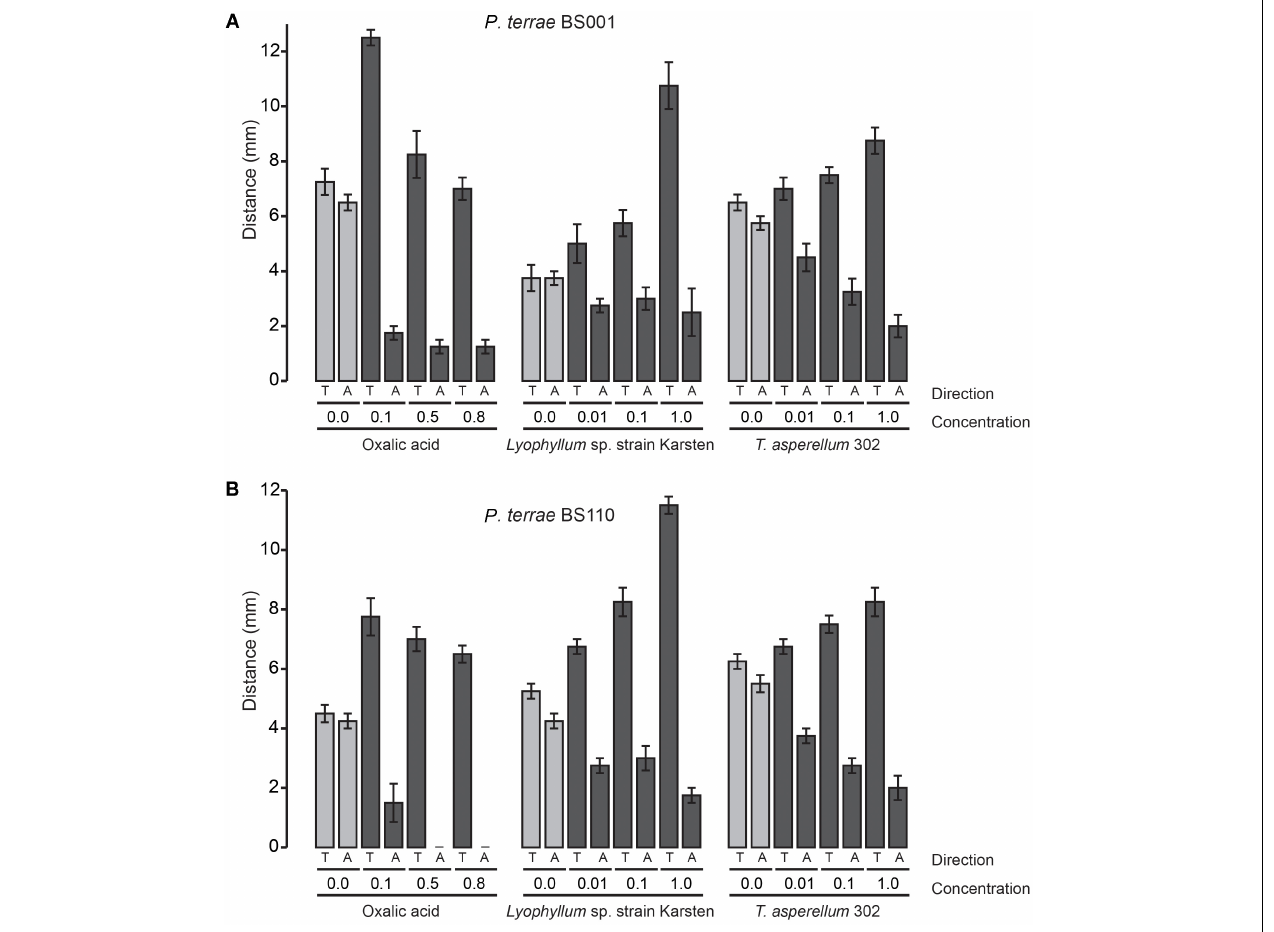
FIGURE 1 | Chemotaxis (swimming) of P. terrae strains BS001 and BS110 toward oxalate and exudates of Lyophyllum sp. strain Karsten and T. asperellum 302 on 0.25% (w/v) M9 medium. (A) The response of P. terrae BS001 to either oxalate or exudates of both fungal strains. (B) The response of P. terrae BS110 either oxalate or exudates of both fungal strains. The Y -axis represents the distance in mm, whereas the X -axis shows the direction of taxis (“toward” is denoted by “T” and “away” by “A”) and concentration of oxalate or levels of fungal exudates. Data are representative of four biological